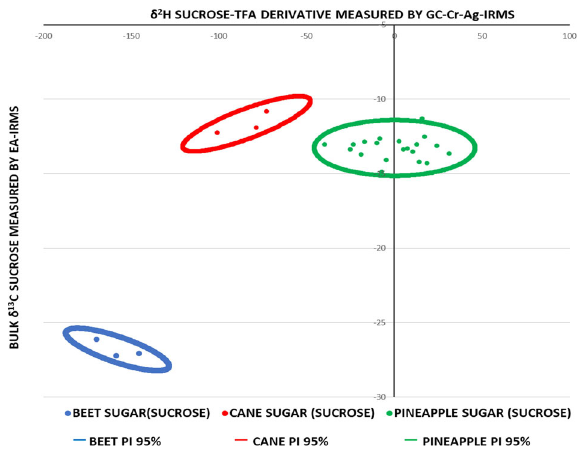
Fig. 3 Plot of authentic pineapple juice, beet and cane sucrose- TFA derivative δ 2 H values versus the corresponding bulk sugar δ 13 C values. In all, 95% prediction interval (PI) ellipses are also shown for each